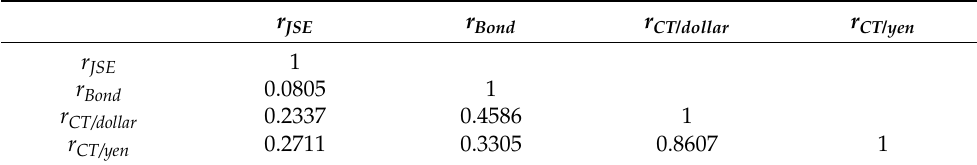
Table 2. Correlation